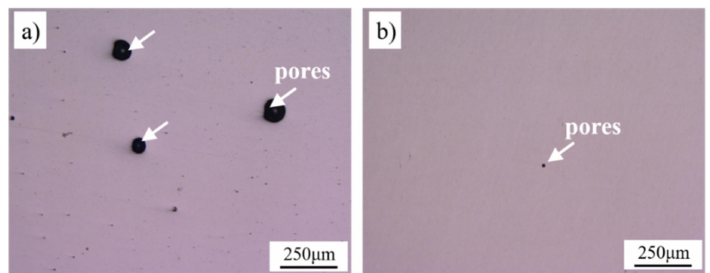
Figure 2. Defects observed on transversal section: ( a ) as-built sample; ( b ) HIPed